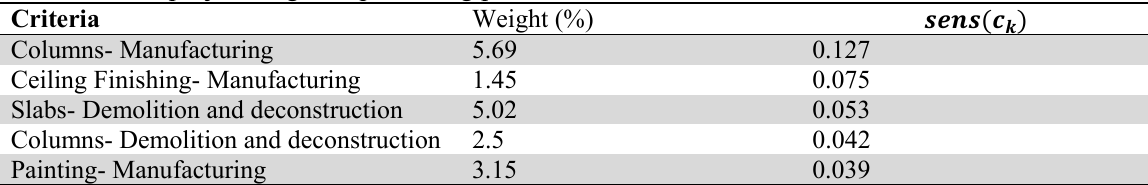
Most sensitive project stages in producing particular matter